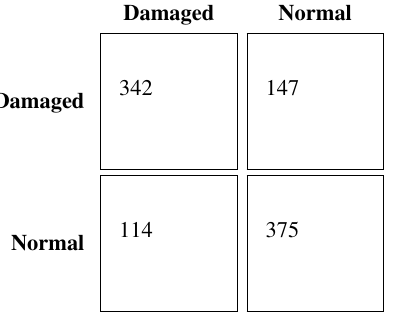
Table 9. Confusion matrix of the Balanced Dataset with data augmentation (flipped